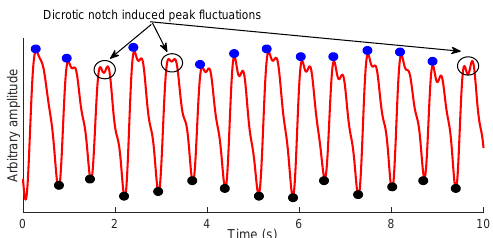
Figure 2. An example of O 2 Hb signal with its corresponding peaks (blue) and troughs